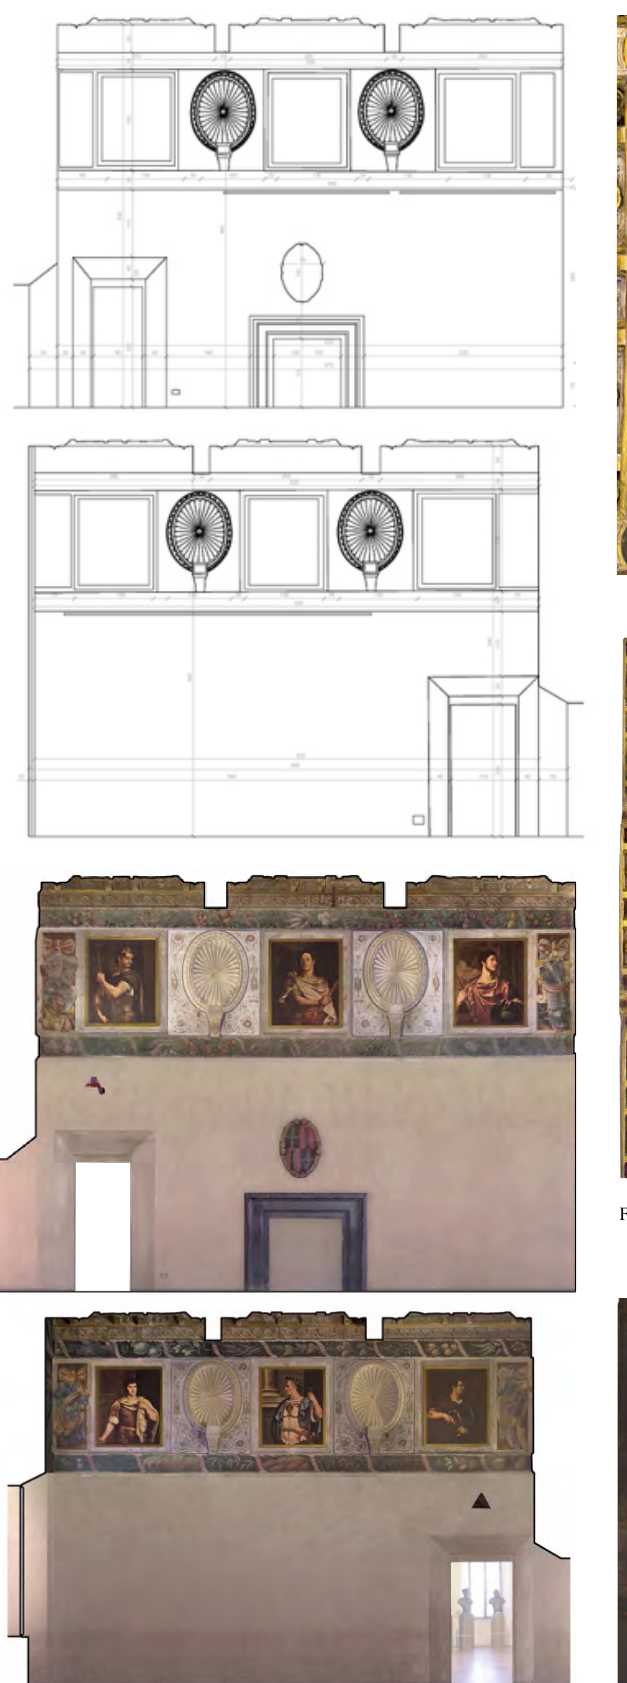
Figure 8. Sections of the room (by photos and by lines) coming from Photoscan projections